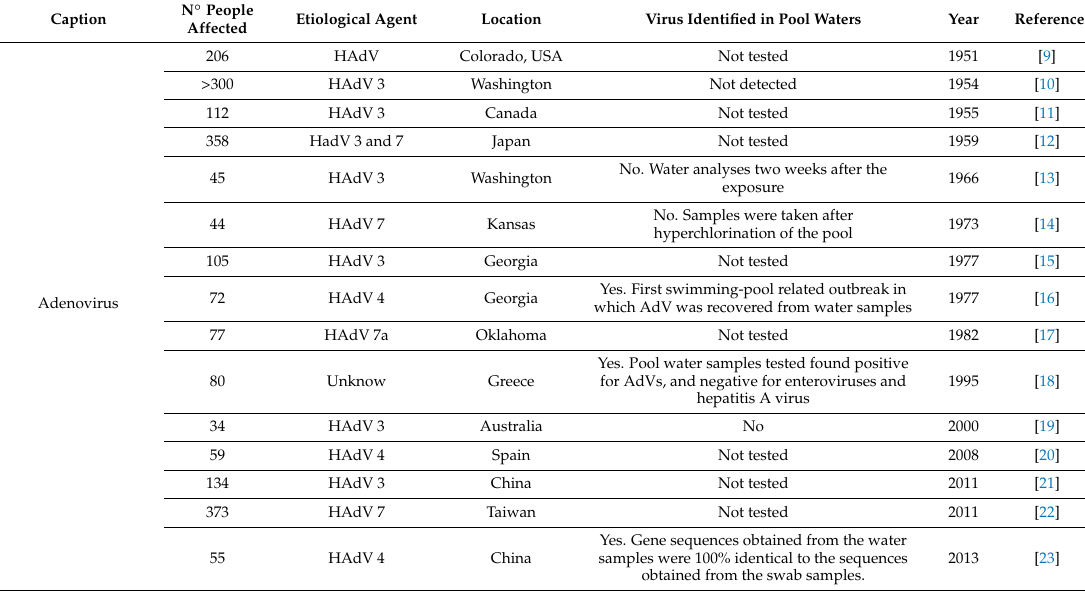
Table 1. List of viral swimming pool-related